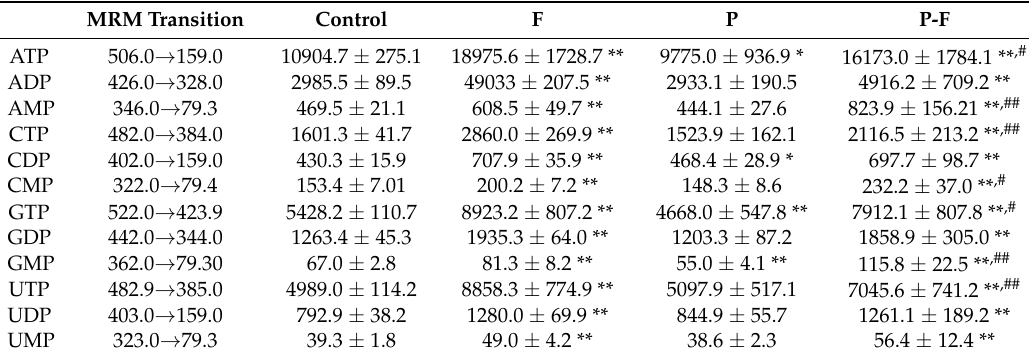
Table 2. Levels of RNs in HepG2 cells of every group (pmol/10 6 cell).